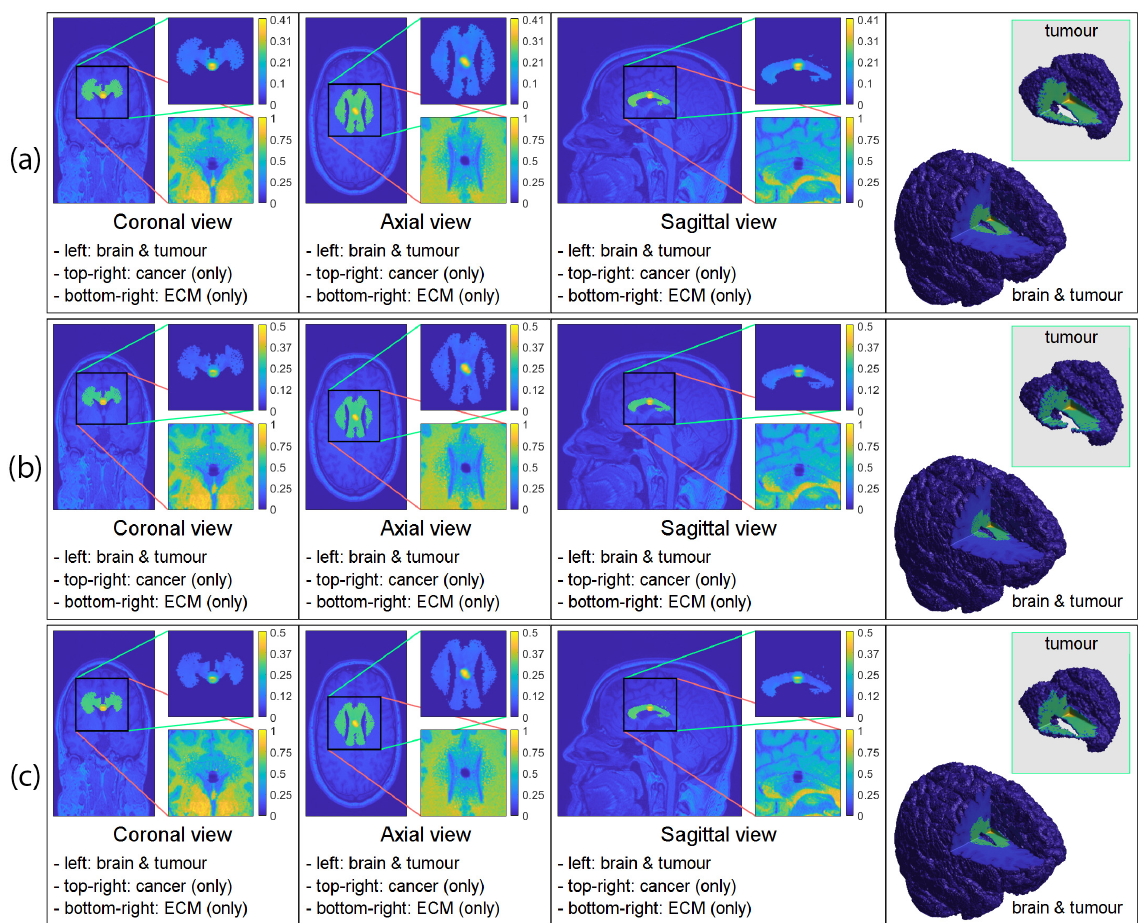
Figure 5. 3D computer simulation results: ( a ) with only white–grey matter dependency ( r = 1); ( b ) with only DTI data used ( D G = 1); ( c ) with both white–grey matter dependency and DTI data incorporated. To represent the simulation results, we use the same format as in Figure